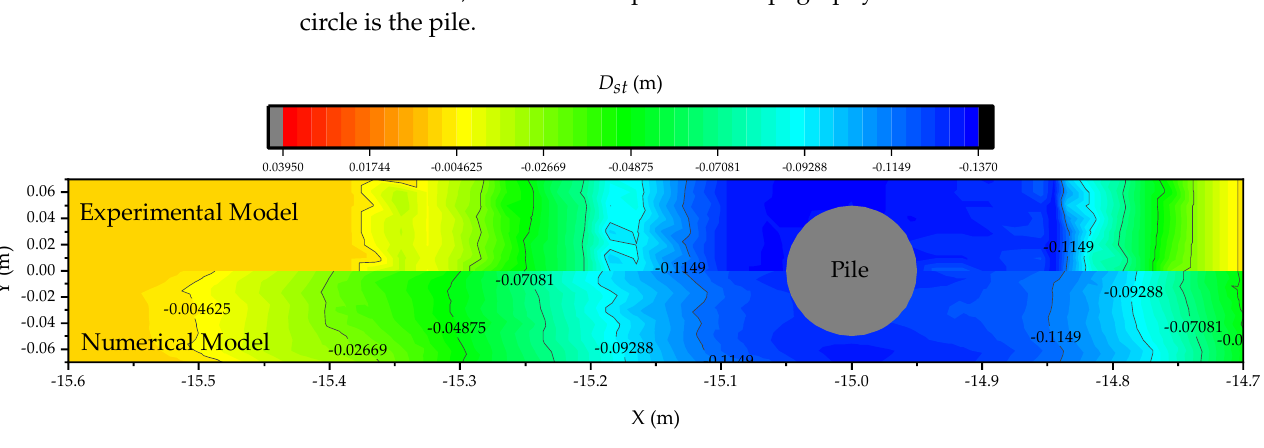
Table 3. Numerical simulations of the present work. Case